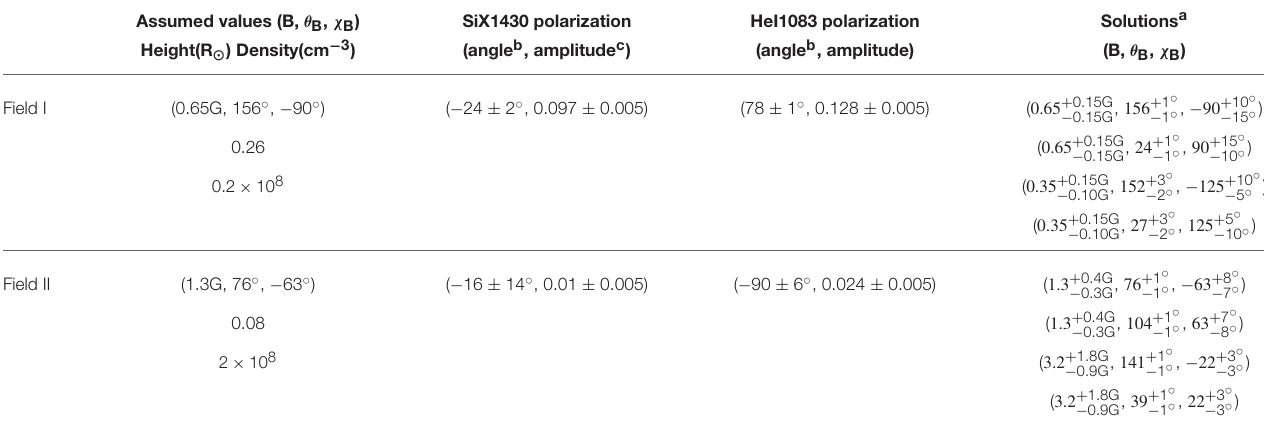
a Parameter errors only account for polarization errors in the HeI1083 line. The error contributions from SiX1430 polarization angle uncertainty is discussed in the text. b Polarization angles are given in the [ − 90 ◦ , 90 ◦ ] domain and the reference direction is along the local solar radial. c Polarization amplitude for SiX1430 are given to show amplitude/noise for each case, but the values themselves are not part of the algorithm.